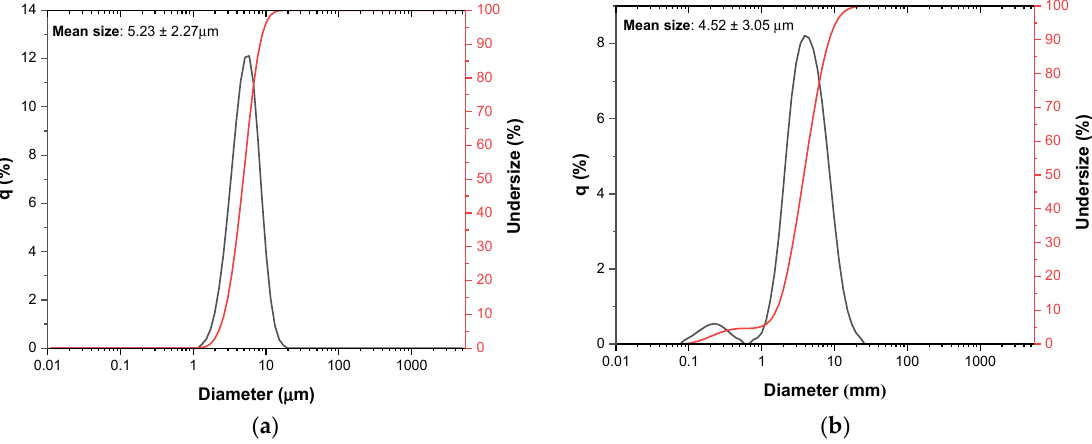
Figure 3. Particle size distribution with laser granulometry for ( a ) base Bioglass ® and ( b ) Zn2.